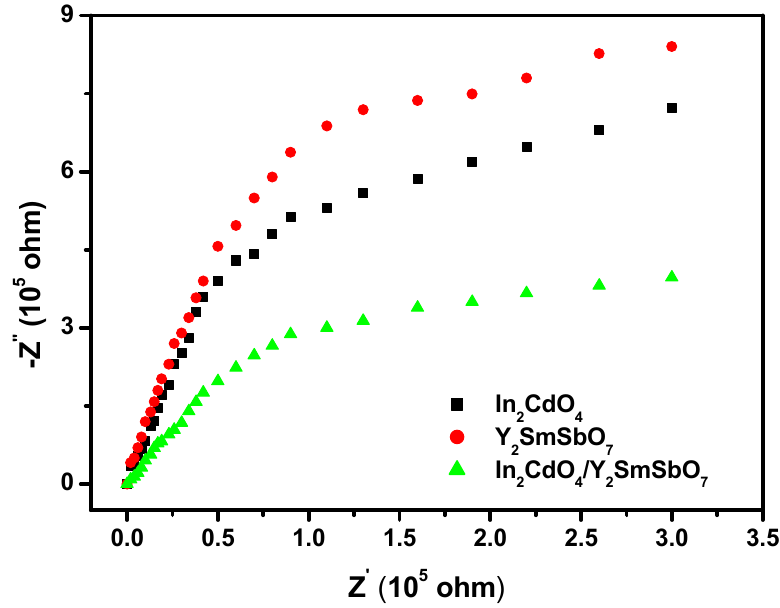
Figure 18. Nyquist impedance plots of In 2 CdO 4 /Y 2 SmSbO 7 nanocomposite, In 2 CdO 4 , or Y 2 SmSbO 7 as photocatalyst.